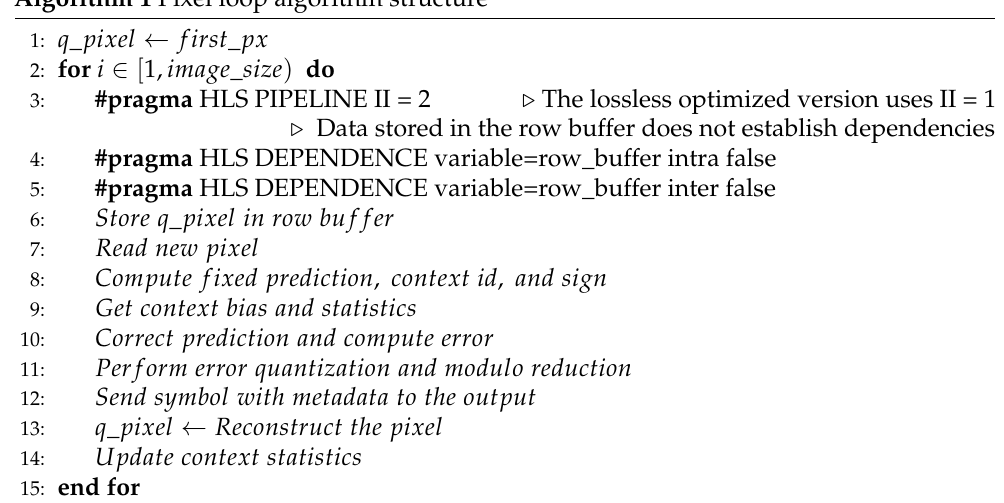
Algorithm 1 Pixel loop algorithm structure